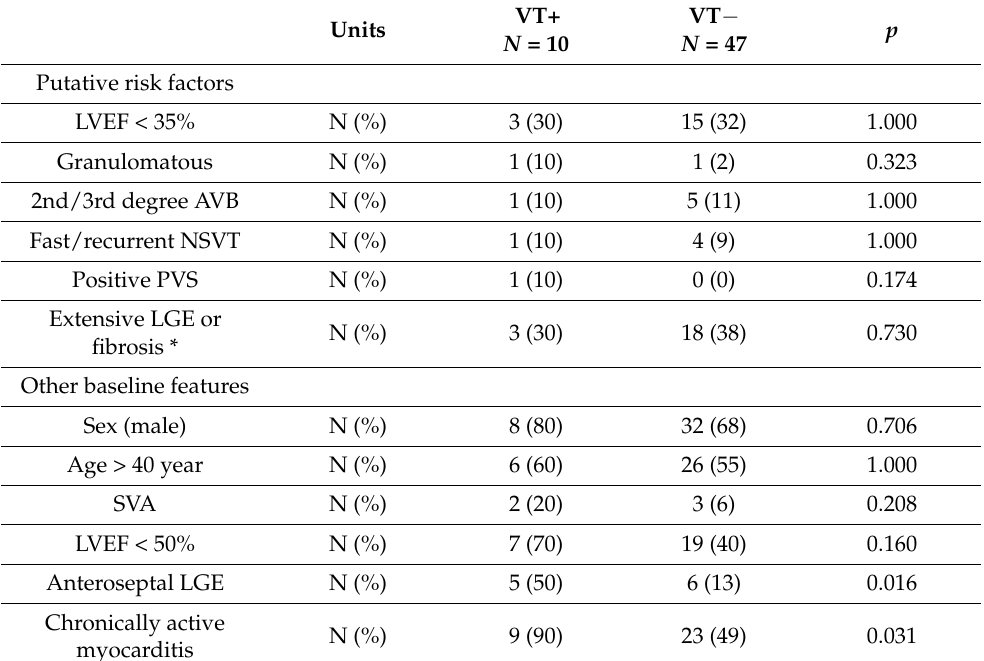
Table 3. Characteristics of primary prevention CAM patients with follow-up VT vs. without follow-up